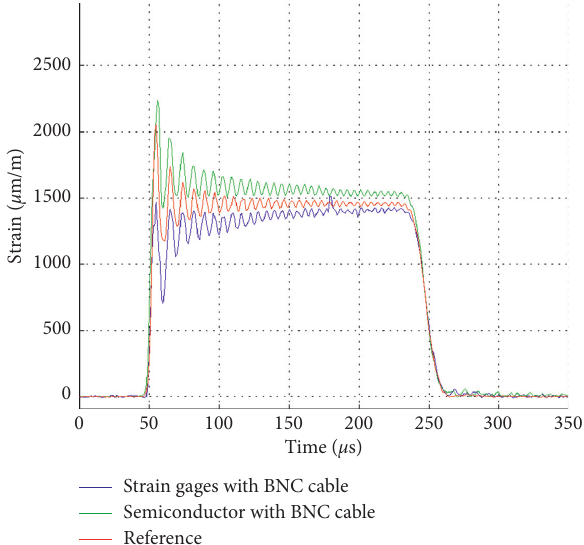
Strain gages with BNC cable Semiconductor with BNC cable Figure 13: SPHB measurement on stainless steel sample, reference taken in the input bar, and acquisition via resistive and semi- conductor strain